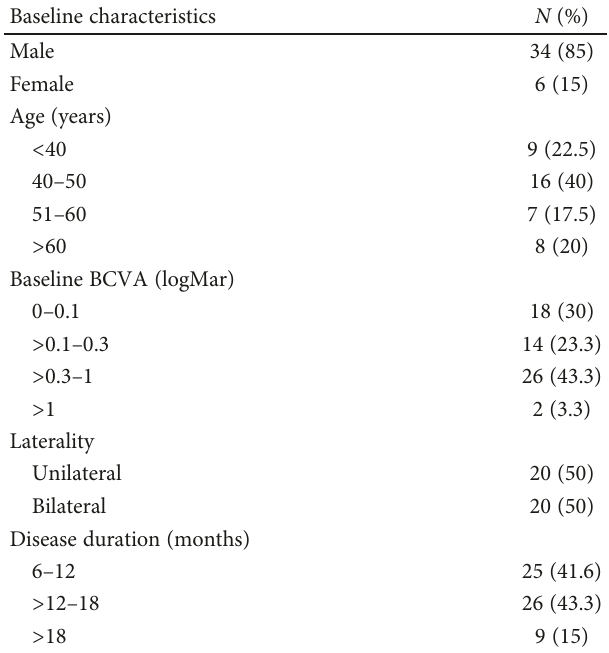
Table 1: Baseline patients ’